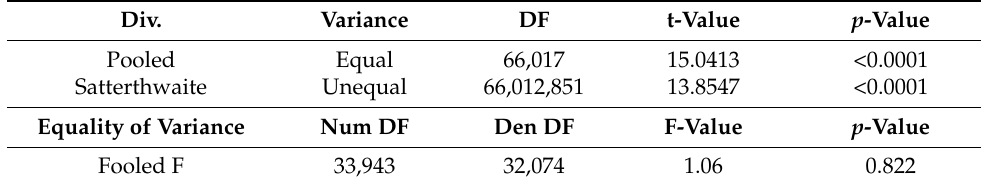
Table 11. Two-sample t -test for H1d testing.